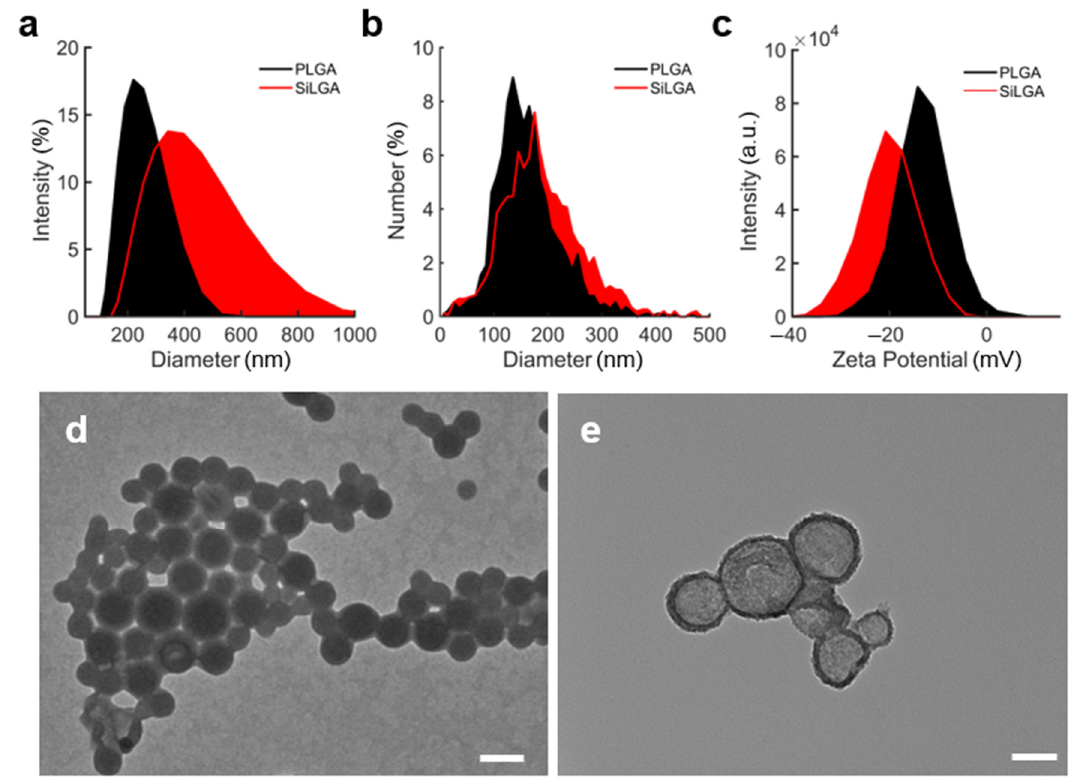
Figure 2. DLS, NTA, and TEM show silica coating: Distributions of ( a ) Cumulant hydrodynamic diameters, ( b ) hydrated diameters, and ( c ) Zeta potential of PLGA (black) and SiLGA (red) NPs. Transmission electron micrographs of ( d ) PLGA NPs (scale bar is 200 nm) and ( e ) SiLGA NPs (scale bar is 100 nm).